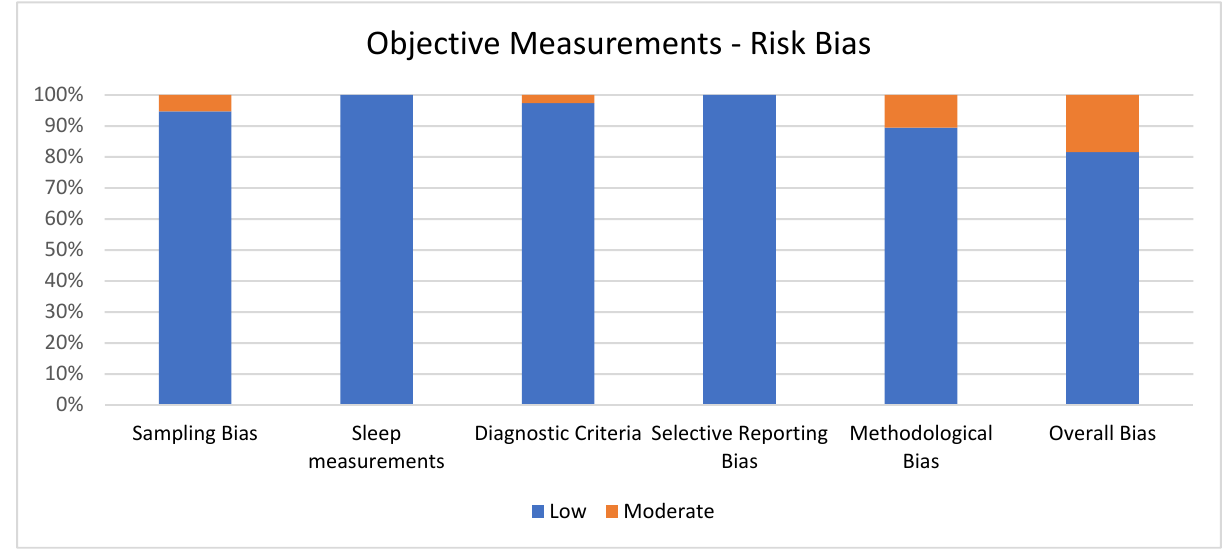
Figure 3. Objective measurements.